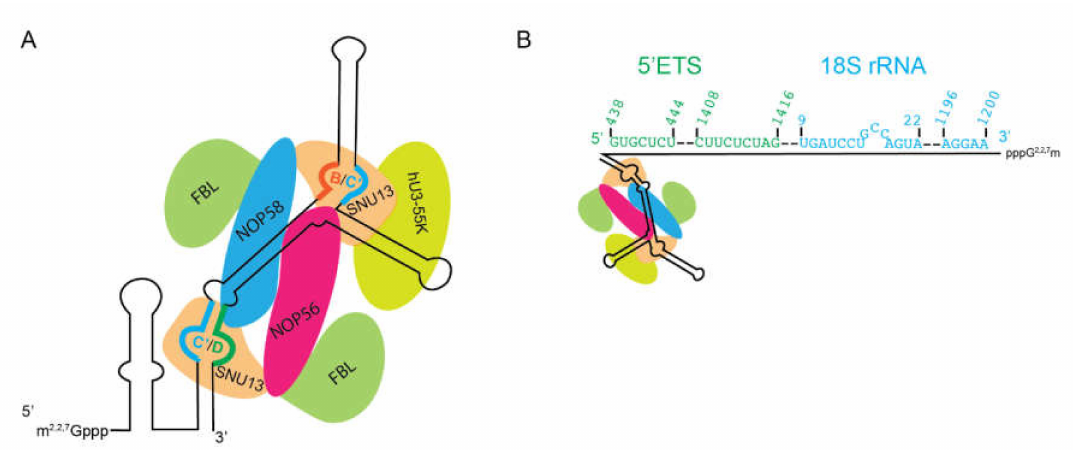
Figure 5. U3 snoRNP. ( A ) Secondary structure of the U3 snoRNA with protein components. Note that SNU13 still binds k-turns, here formed by Box C (cid:48) (blue) and Box D (green) and Box C (cid:48) (blue) and Box B (Red). The altered structure of the U3 snoRNA results in FBL not being positioned for 2 (cid:48) -O- methylation. ( B ) The 5 (cid:48) extension forms multiple base-pairs with the pre-rRNA. Two di ff erent stretches in the 5 (cid:48) ETS (green) and the 18S rRNA (blue) are bound. Dashed lines indicate looped-out stretches of rRNA. Numbers indicate position in the 47S rRNA (green) or 18S rRNA (blue). Note that this schematic does not fully represent looping out. Secondary structure modified from predictions on snoRNABase